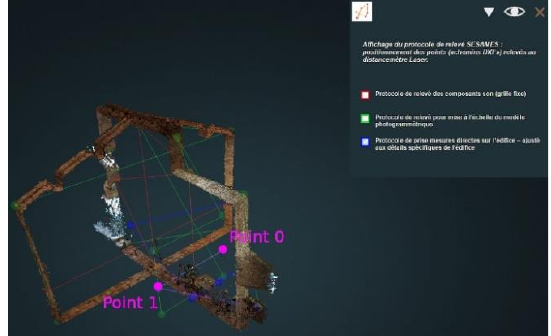
Figure 3 : the three polylines corresponding to the three DXF files : acoustic devices (red), scaling of the model (green) and direct measurements